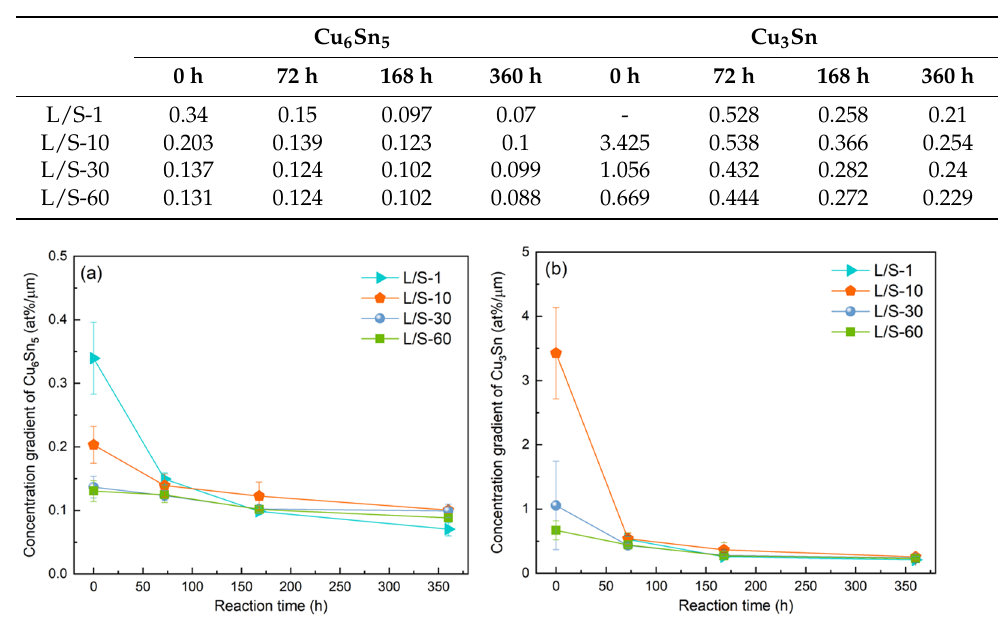
Figure 7. Magnitudes of |Δ C Sn / Δ x | (absolute value) of ( a ) Cu 6 Sn 5 and ( b ) Cu 3 Sn as a function of the S/S reaction time.